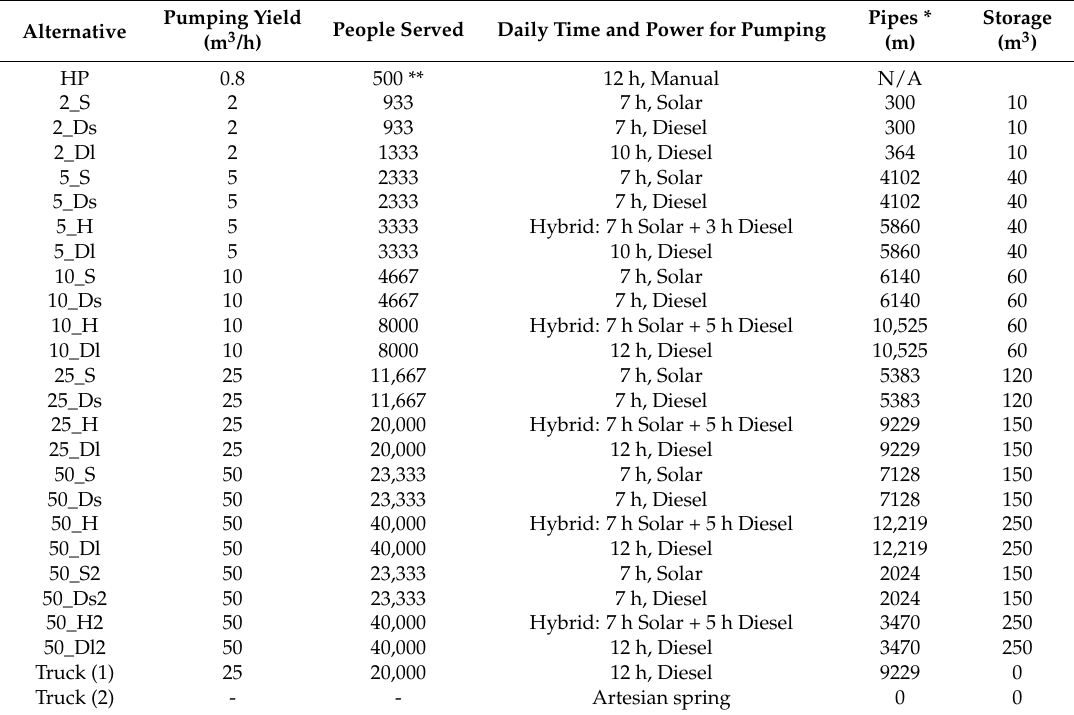
Table 3. Technical characteristics of the assessed alternatives. Details in Supplementary Material A.5. Truck (1) indicates that the water source is the same as in the 25_Dl; Truck (2) models water trucking assuming a no-cost water source (e.g., artesian spring). * Includes transmission and distribution pipes. ** Limit set by the SPHERE